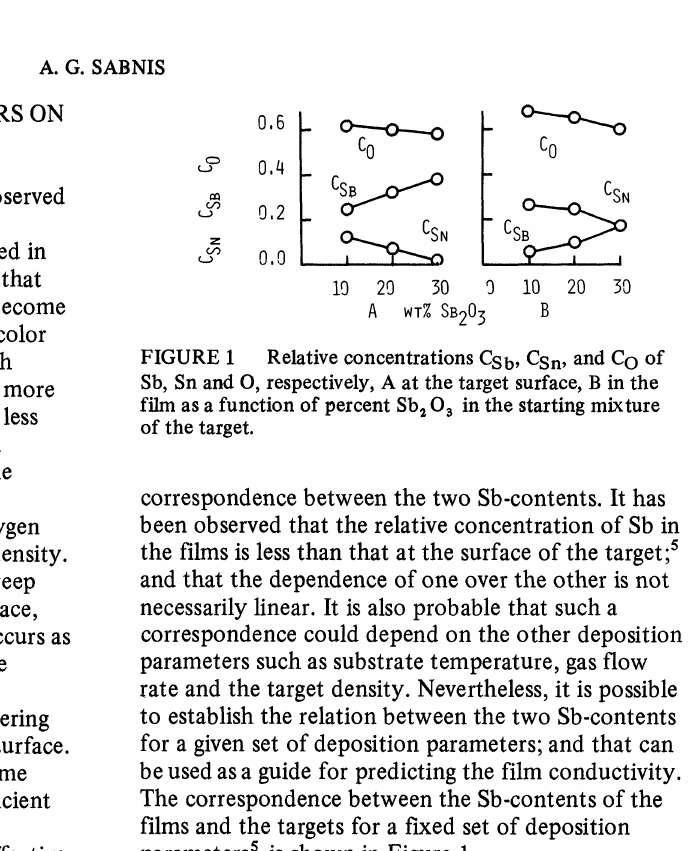
FIGURE Relative concentrations CSb, CSn, and C O of Sb, Sn and O, respectively, A at the target surface, B in the film as a function of percent Sb O in the starting mixture of the